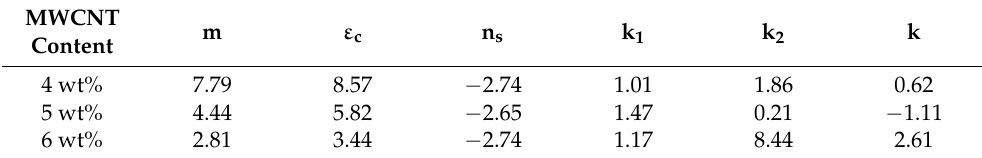
Table 3. ∆ R/R 0 parameters after strain curve fitting for the different MWCNT/VMQ-DBPMH composites. MWCNT